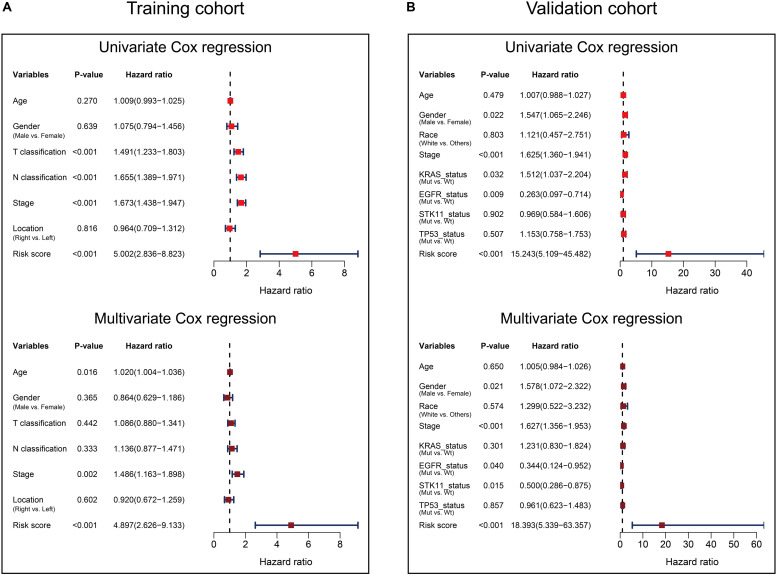
Forest plot summary of Cox analyses of prognosis. Univariate (upper) and multivariate (bottom) analyses based on the eight-gene signature and clinical covariates in training cohort based on overall survival (A) and validation cohort based on overall survival (B). The colored solid squares represent the hazard ratio (HR), and the transverse lines through HR represent 95% confidence intervals (CI). All p values were calculated using the Cox regression hazards analysis.